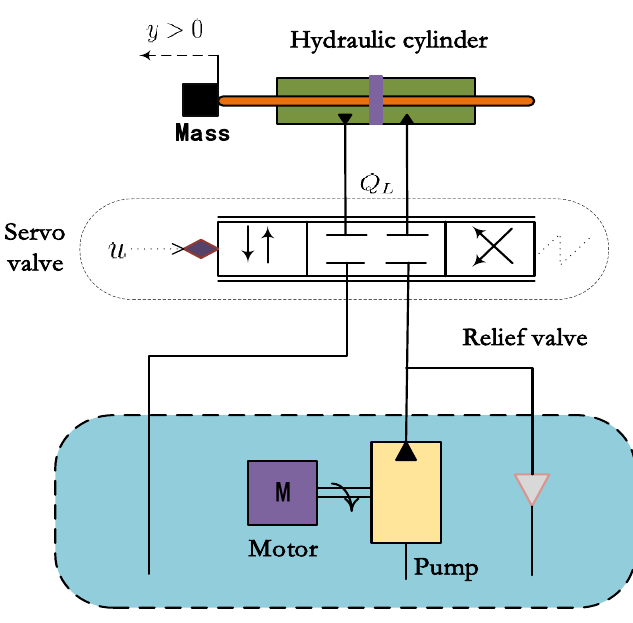
Figure 1. The EHS